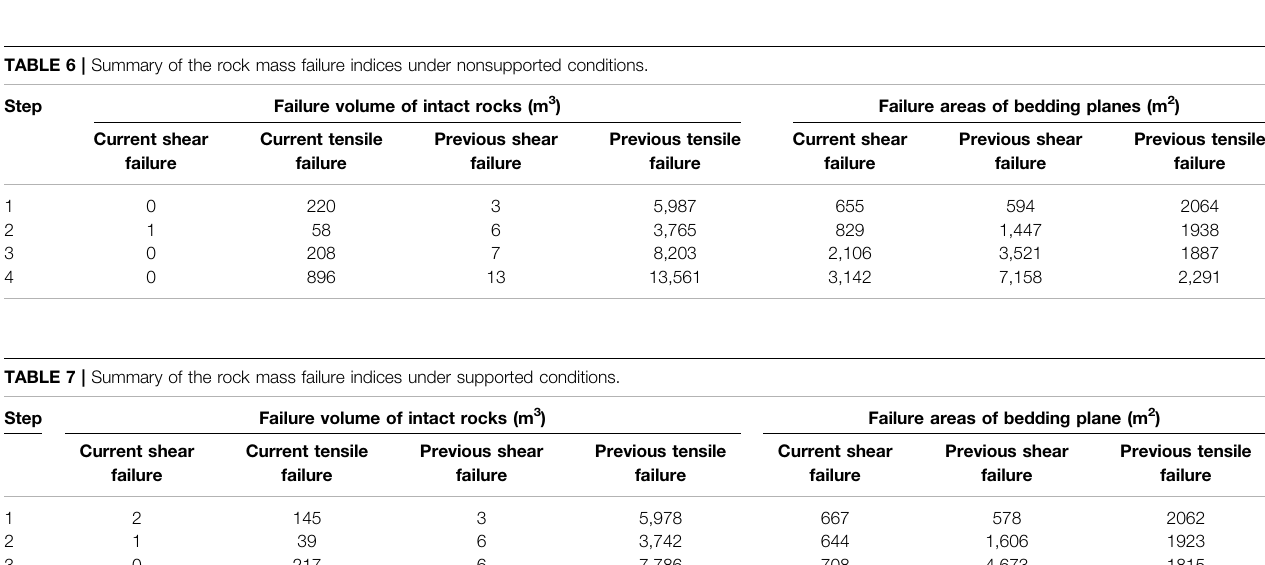
FIGURE 10 | Contour plot of the deformation distribution after step 4 excavation under the supported and unsupported conditions (Unit: mm). (A) non-supported condition, (B) systematic support condition.